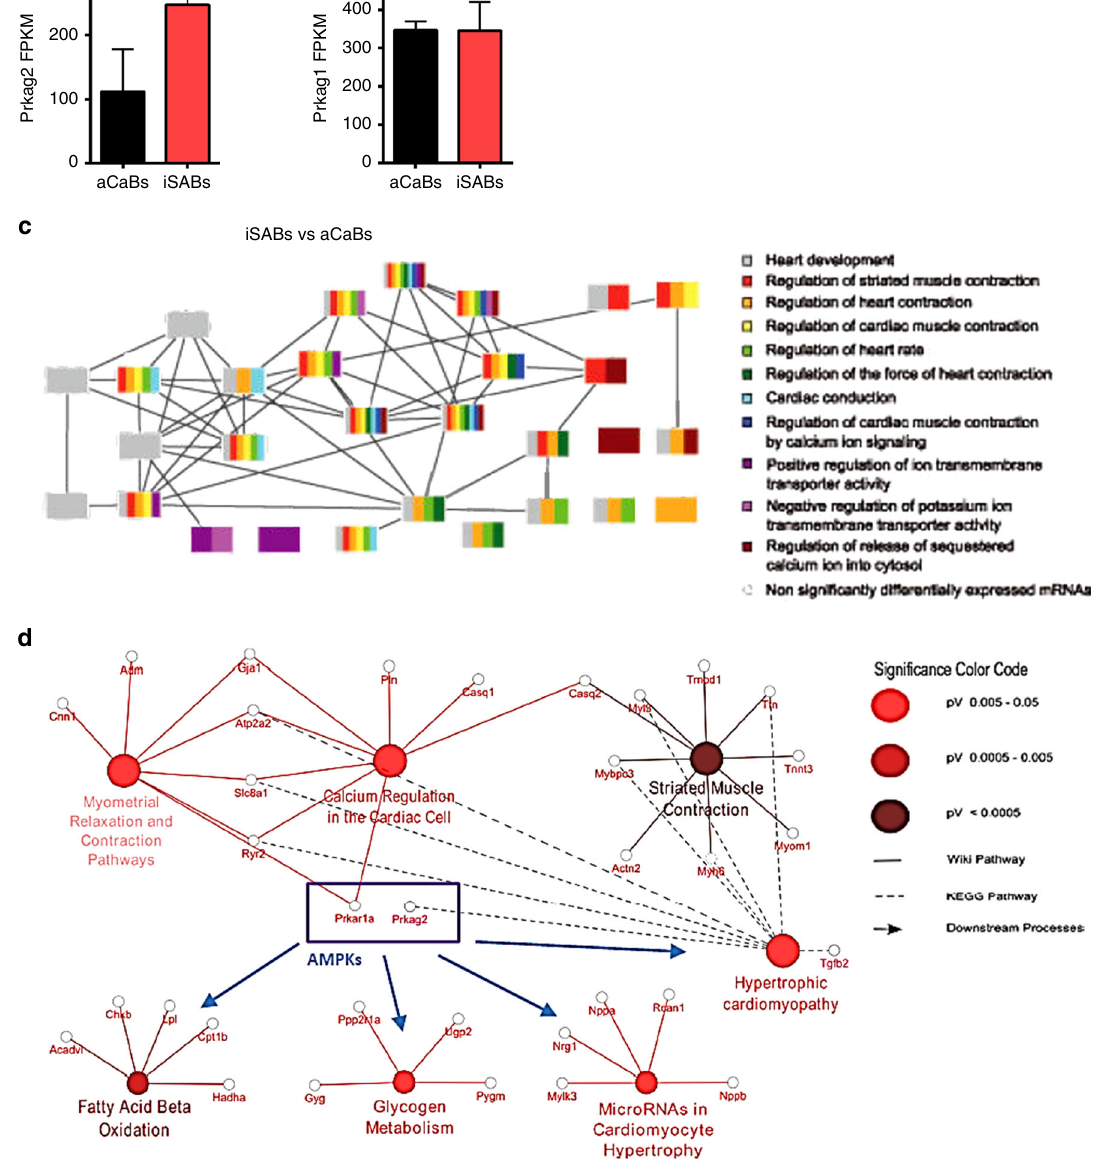
Fig. 3 RNA-Seq-derived expression levels of γ AMPK isoforms and gene ontology analysis of iSABs vs aCaBs. a , b Prkag2 ( a ) and Prkag1 ( b ) gene expression in iSABs (induced sinoatrial bodies) vs aCaBs (antibiotic-selected cardiac bodies — a mixture of cardiomyocyte subtypes) by RNA-Seq ( n = 3). c , d Functional annotation with gene ontology (GO) analysis of iSAB gene expression identifying enrichment of GO terms associated with pacemaking ( c ) and signi fi cant enrichment of AMPK-dependent downstream targets and ontological processes ( d ). a , b Data are shown as means ±